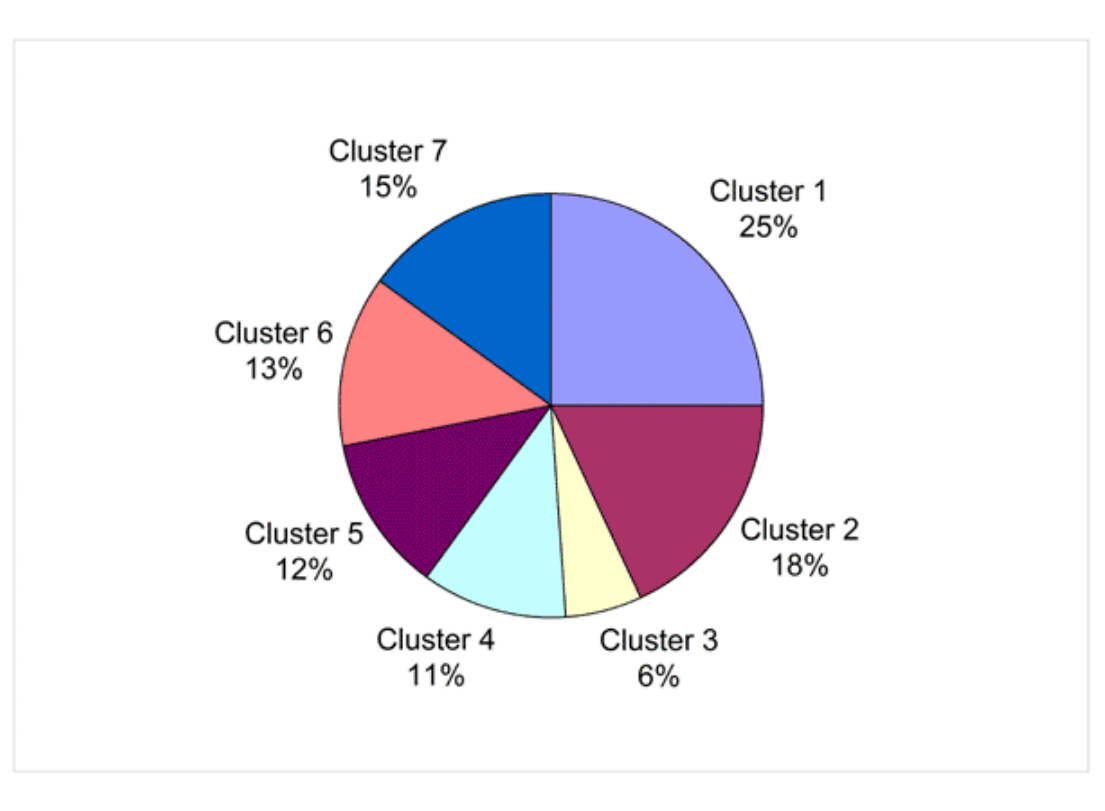
Fig. 3. The frequency of agents in each cluster according to the results of the analysis of the Detroit Area Study (Fernandez et al.